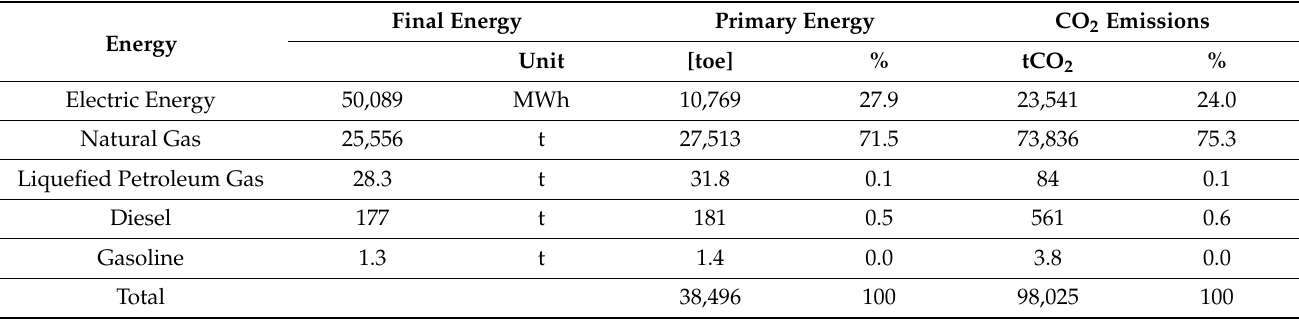
Table 1. Annual primary energy consumption and CO 2 emissions from IECMS installations